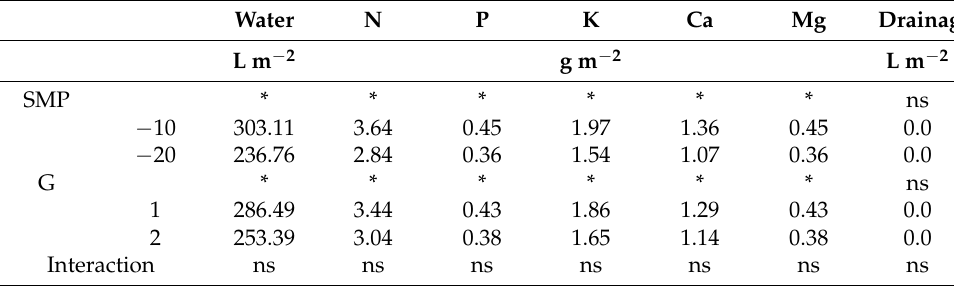
Table 3. Total water and nutrients applied and drainage